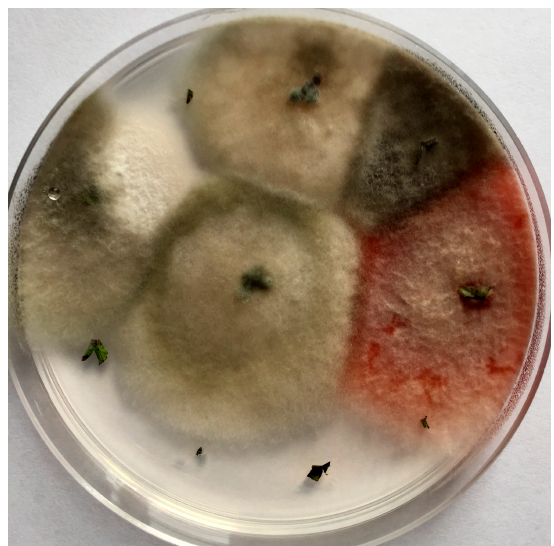
Figure 1. Isolation of endophytic fungi from leaf of Salvia yangii (original from work currently in progress at our laboratories).